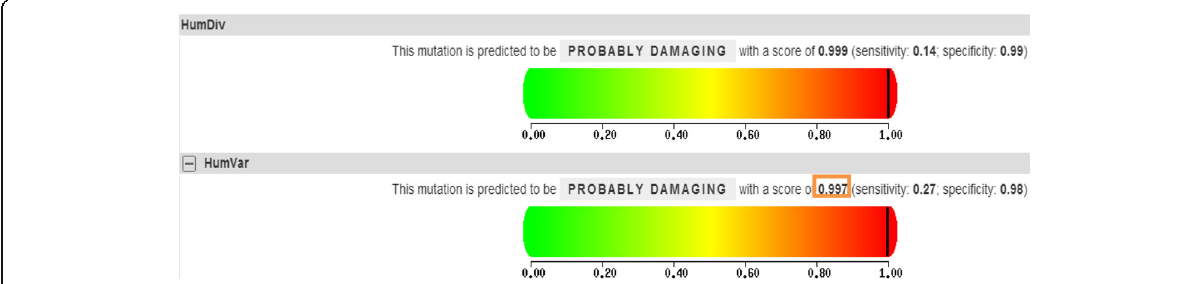
Fig. 5 The pathogenicity prediction of the mutation site of c.878 T > G using the software PolyPhen-2. The mutation prediction is based on the results of second graph HumVar. The closer the score is to 0.00, the less possibility causing protein damage. The score of c.878 T > G was 0.997, which was close to 1.0, indicating that it theoretically had high pathogenicity and potentially caused